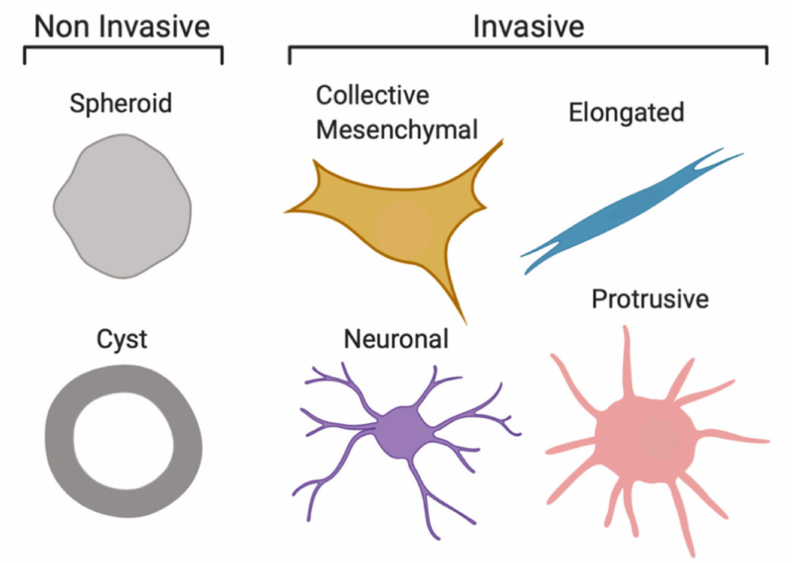
Figure 7. Schematic illustration of distinct morphological phenotypes observed in 3D invasion assays. Six distinct phenotypes in NB organoids isolated from PDXs were identified. Round organoids with no protrusions were termed “spheroid” and round organoids containing a lumen “cyst” due to their cyst-like appearance. Cells invading as collective strands with actin-rich protrusions (indicative of cells with mesenchymal traits) at the leading edge displayed a “collective mesenchymal” phenotype. These organoids contained strands invading in multiple directions. The “elongated” phenotype also displayed collective strand invasion, although multicellular streaming was present as well. Cells also migrated in a common direction leading with long actin-rich protrusions. “Neuronal” organoids invaded collectively as a dispersed network with transient cell–cell contacts; protrusions were neurite-like. The “protrusive” phenotype displayed a radial pattern of neurite-like protrusions, where cells migrated individually or were followed loosely by multicellular